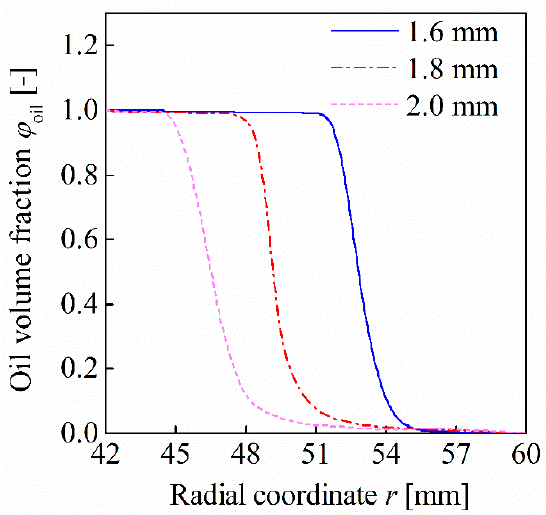
Figure 10. Average oil volume fraction curves at different radial positions with different disk spacing.